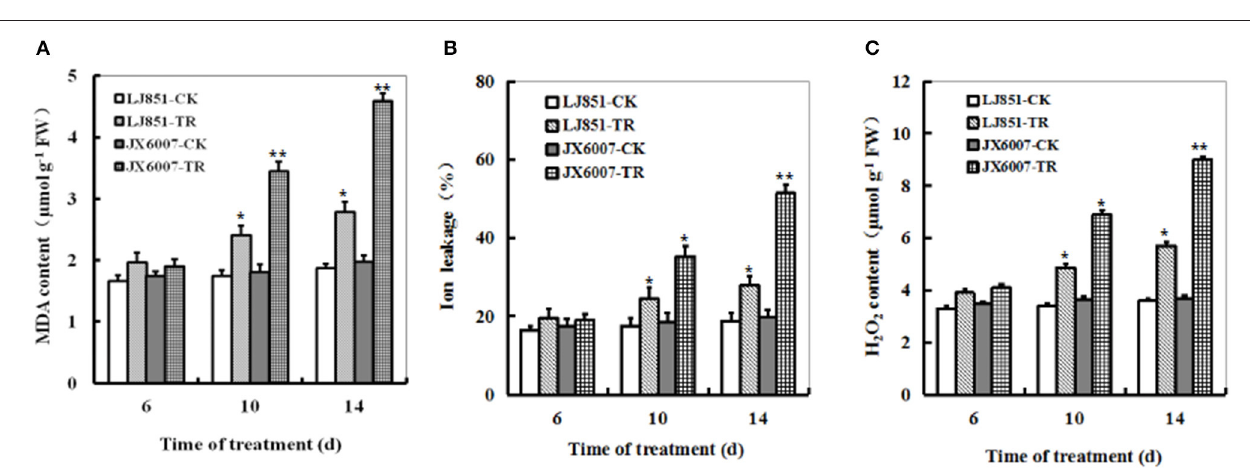
those observed in LJ851 (9 and 25% reductions for 10- and 14-d, respectively). Relative changes in stomatal conductance ( Gs ) were similar to the changes seen in Pn after drought stress, with the